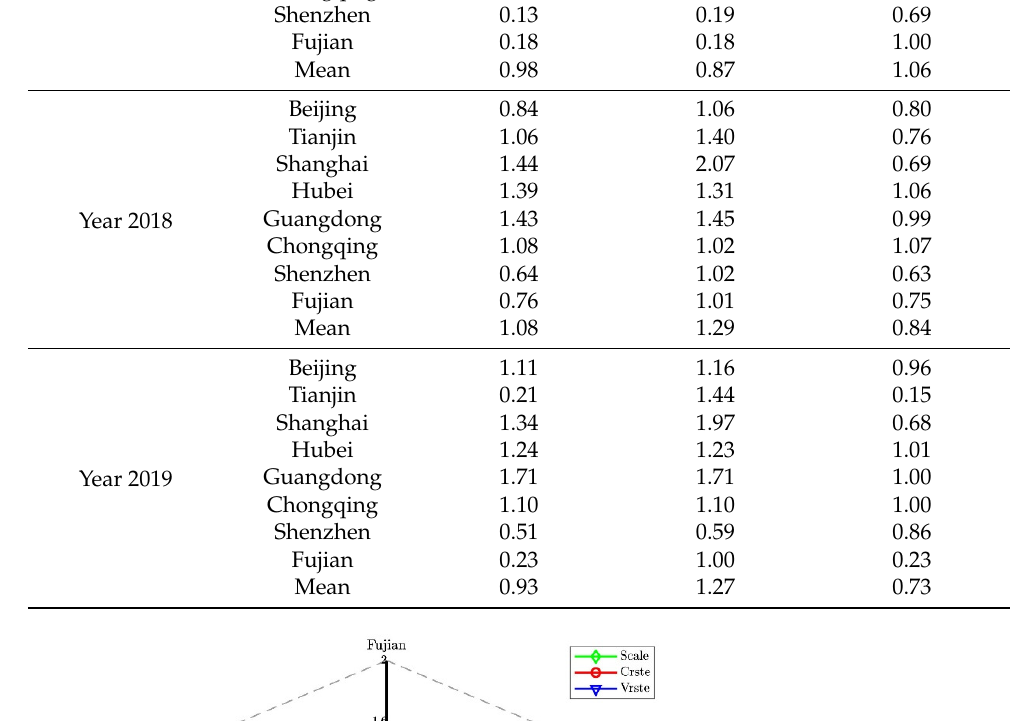
Table 4. The results of DEA efficiency evaluation.